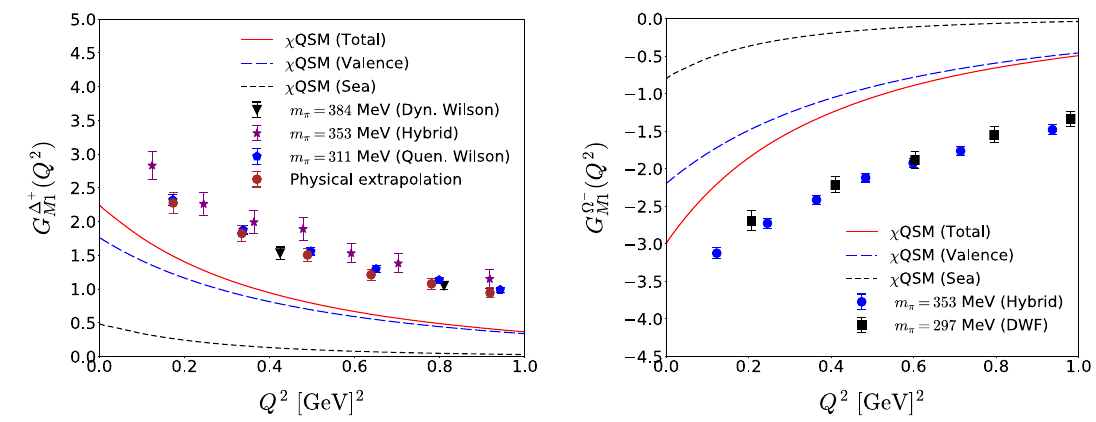
Fig. 3 Contributions of the valence and sea quarks to the magnetic dipole form factors of the (cid:2) + isobar and (cid:5) − in the left and right panels, respectively. Notations are the same as in Fig. 1. The lattice data are taken from Refs.